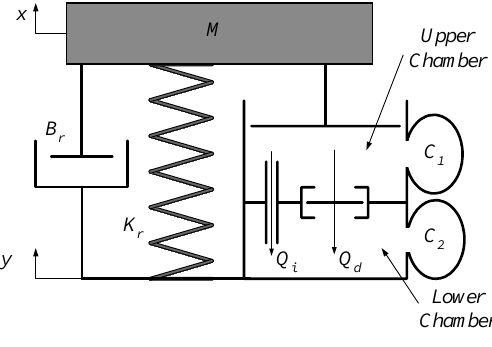
Fig. 3. Lumped parameter model of the hydraulic engine